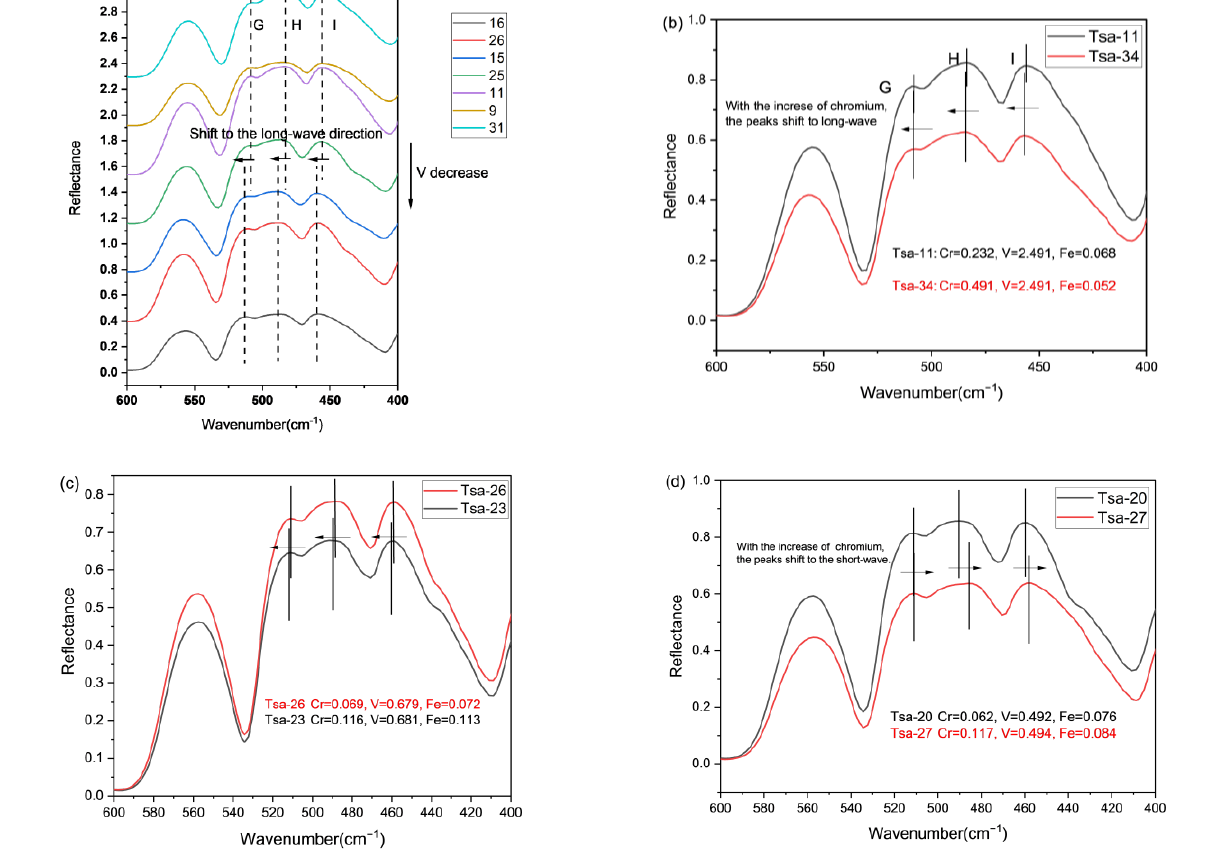
Figure 9. ( a ) With the decrease of vanadium, the peaks shift to long wave; ( b , c ) with the increase of chromium, the peaks shift to long wave; ( d ) with the decrease of chromium, the peaks shift to long wave.